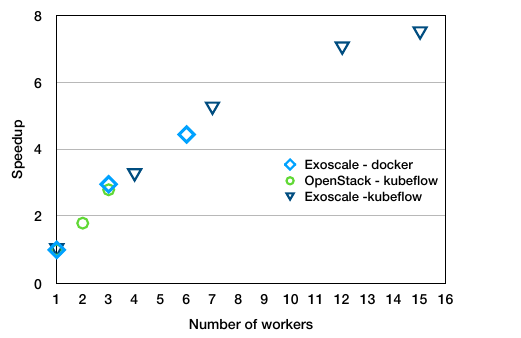
Figure 6. Speed-up for training 3DGAN, as a function of the number of MPI workers and with respect to training with one MPI